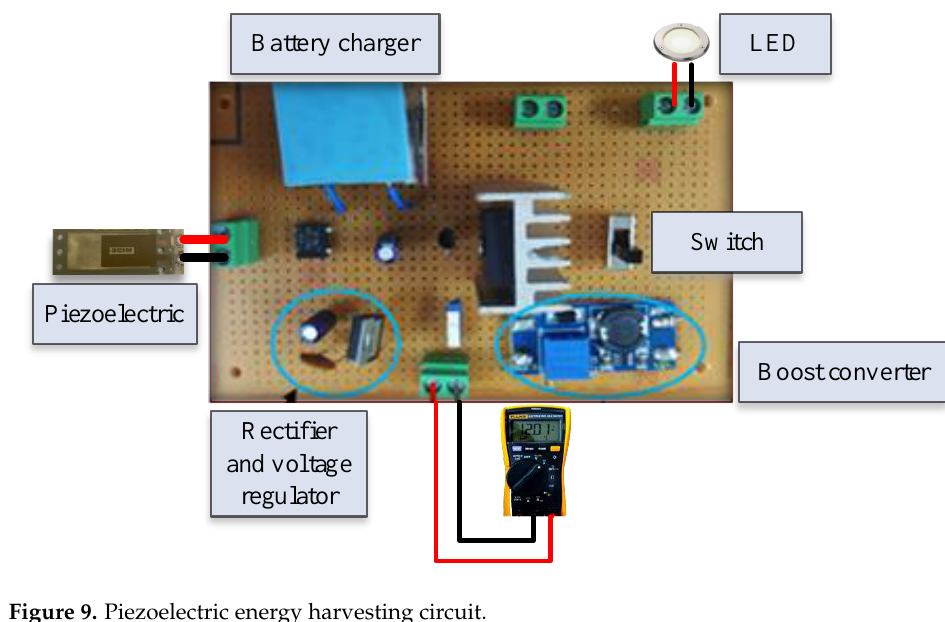
Figure 9. Piezoelectric energy harvesting circuit.